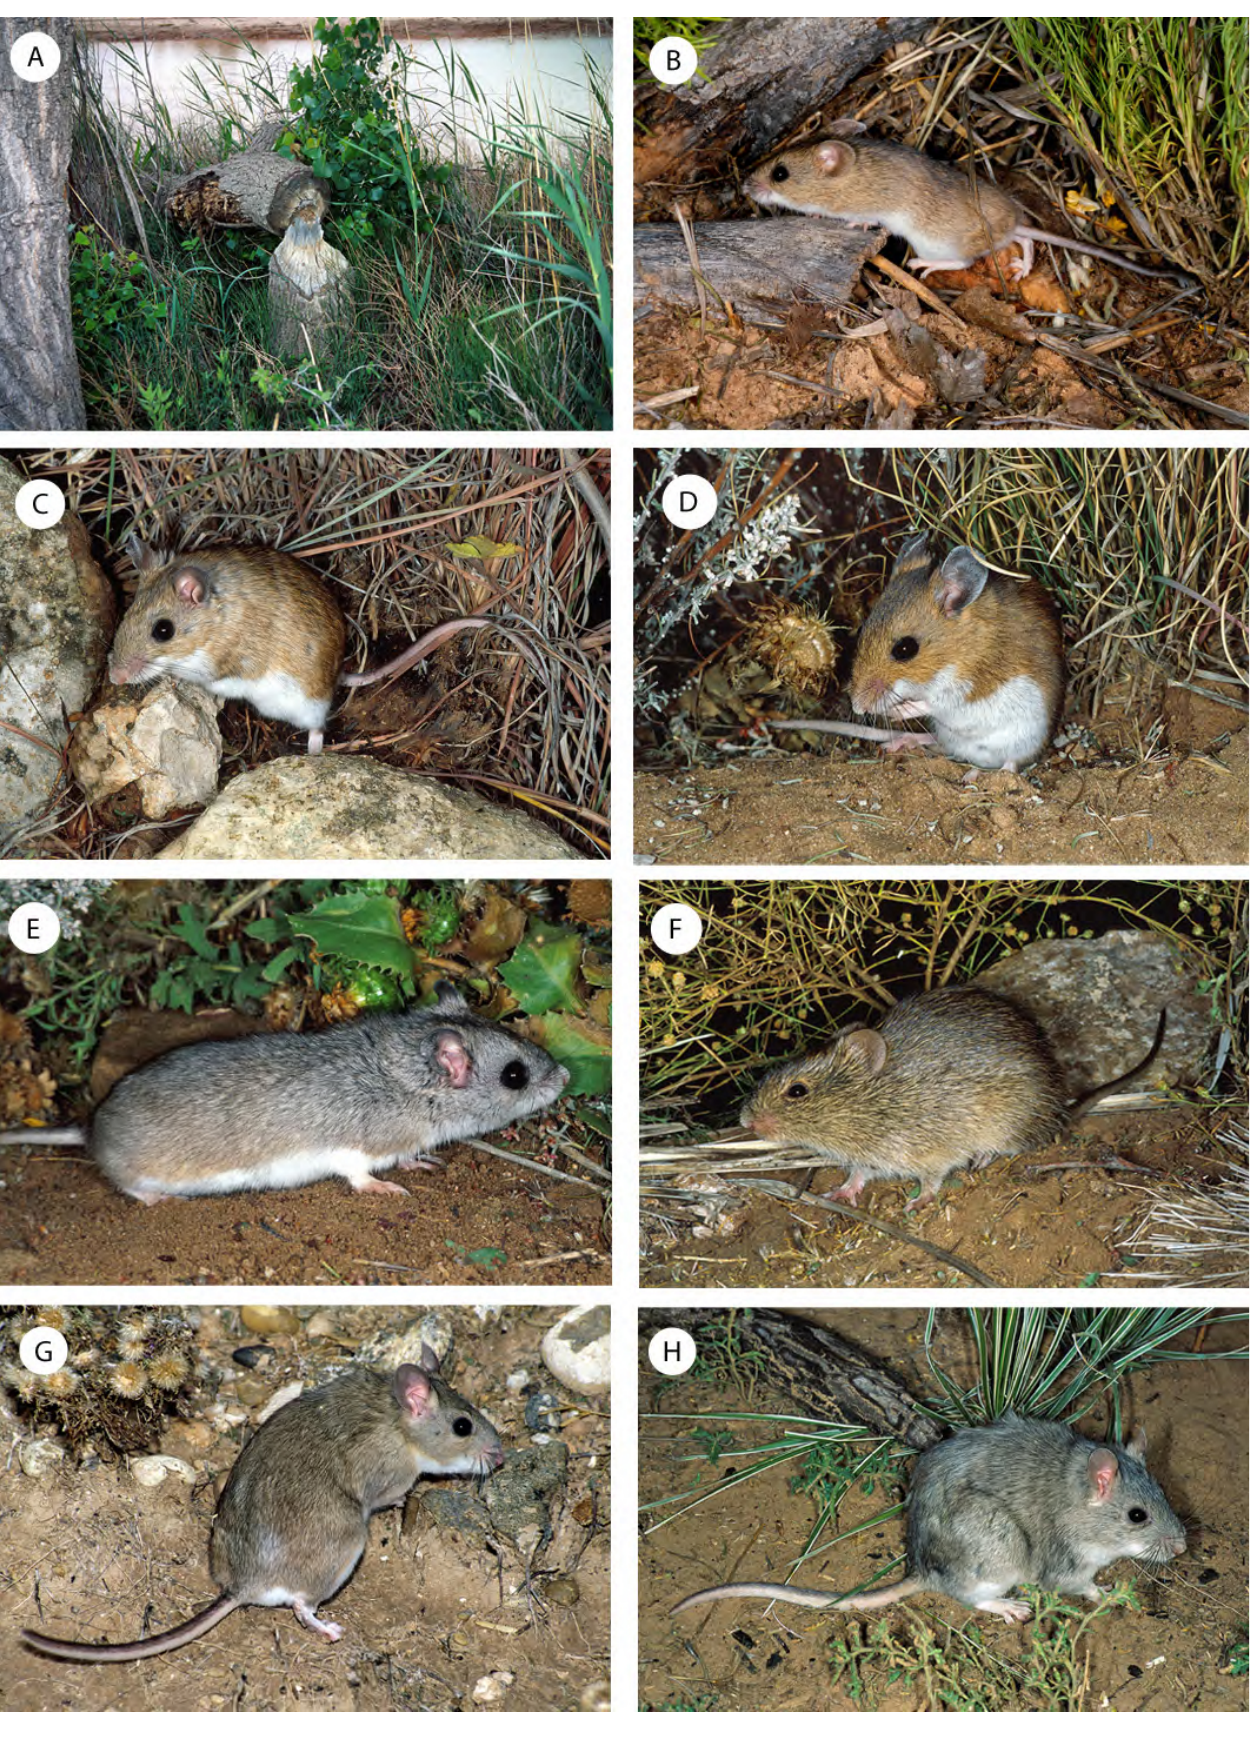
Figure 4. Mammals found in Lake Meredith National Recreation Area, Texas: A : Tree felled by Castor canadensis , B : Reithrodontomys megalotis , C : Pero- myscus leucopus , D : Peromyscus maniculatus , E : Onychomys leucogaster , gray phase, F : Sigmodon hispidus , G : Neotoma leucodon , H : Neotoma micropus . Photographs by Michael